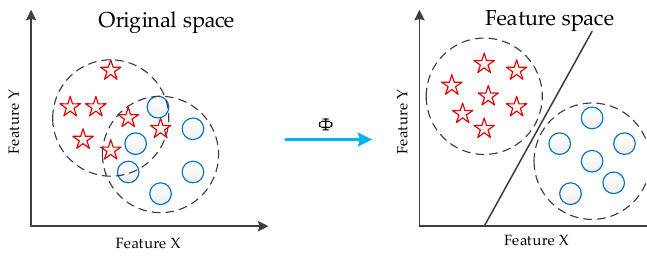
Figure 1. Illustration of nonlinear mapping.